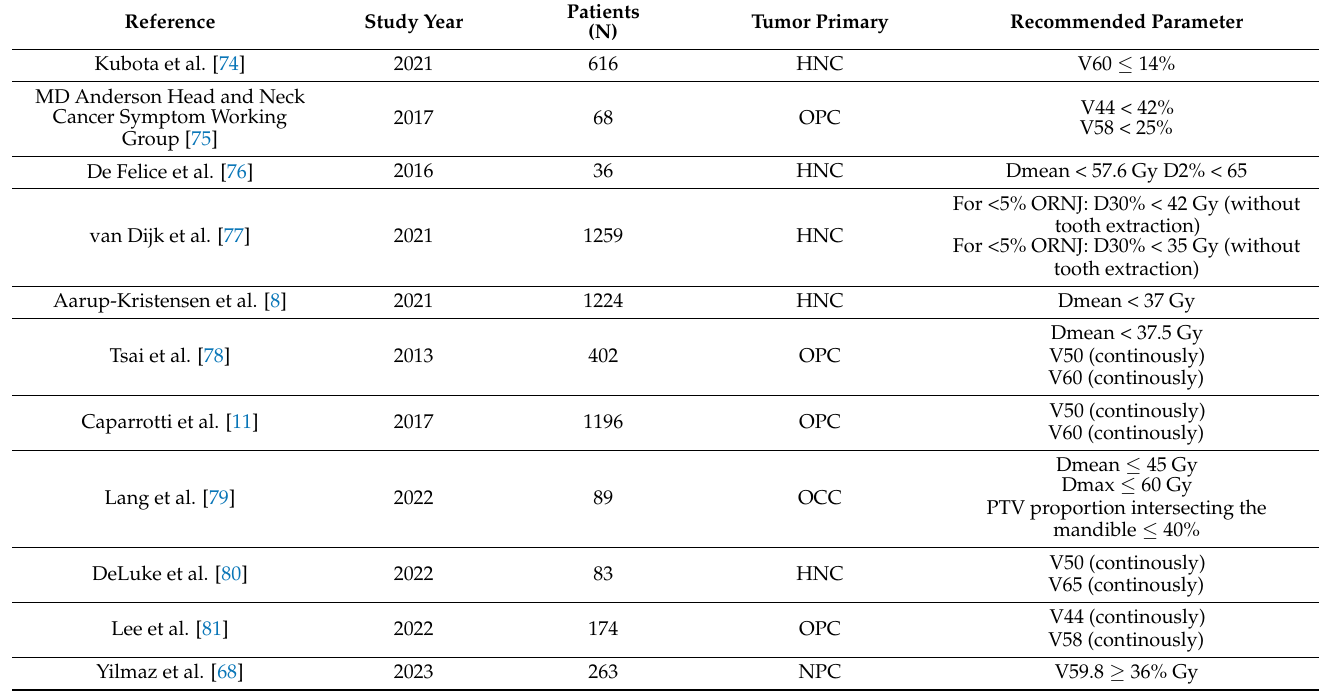
Table 2. Accessible published dosimetric parameters associated with ORNJ